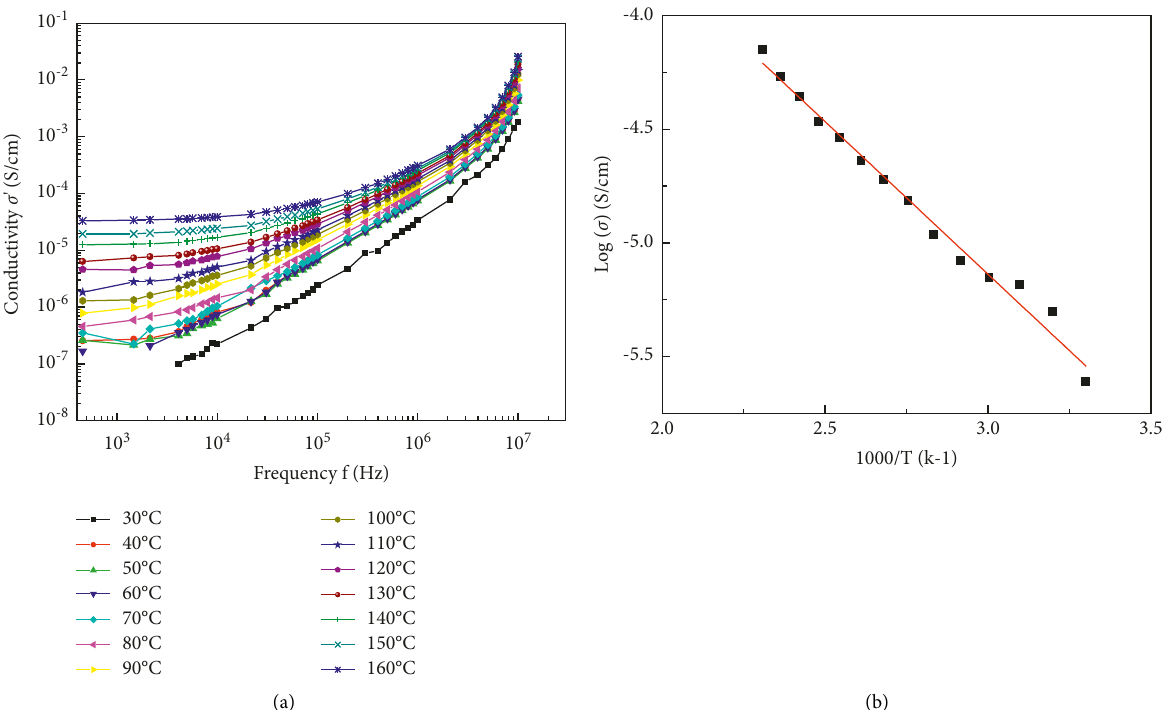
vs. Z ) for PVA/PVP/FeCl 2 blend electrolyte samples (a) at 80 ° C and (b) at 110 ° C. ′ ″